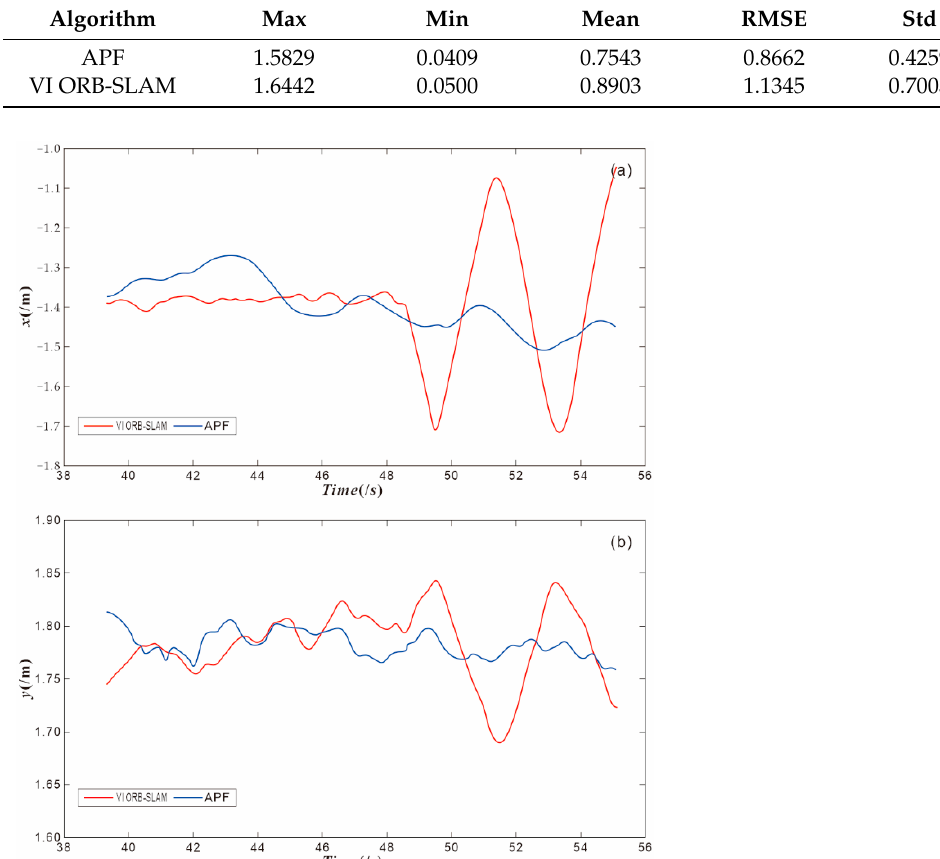
Table 5. Error analysis of the proposed algorithm and VI ORB-SLAM algorithm.